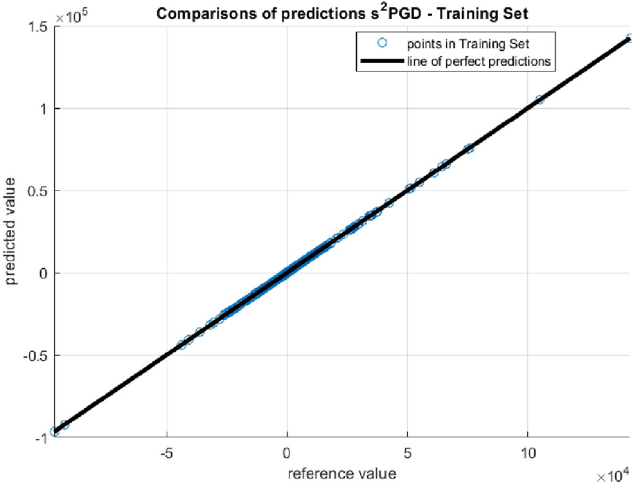
Fig. 11 Problem defined in Eq. 4.5: Comparison of predicted s 2 -PGD values with the reference ones in the training set (the black line represents a perfect